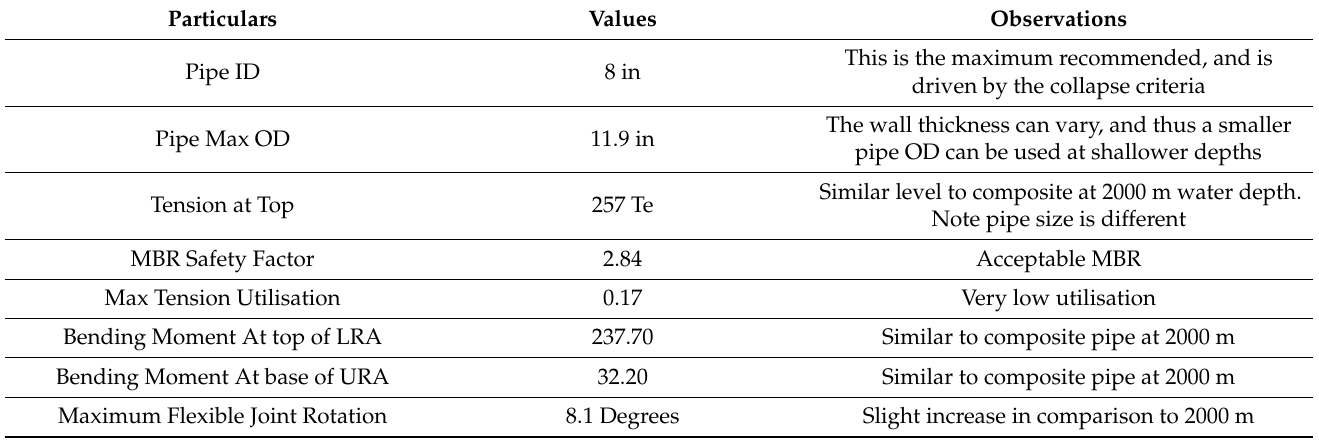
Table 11. Main results obtained for composite risers designed for 4000 m depth. (Source: